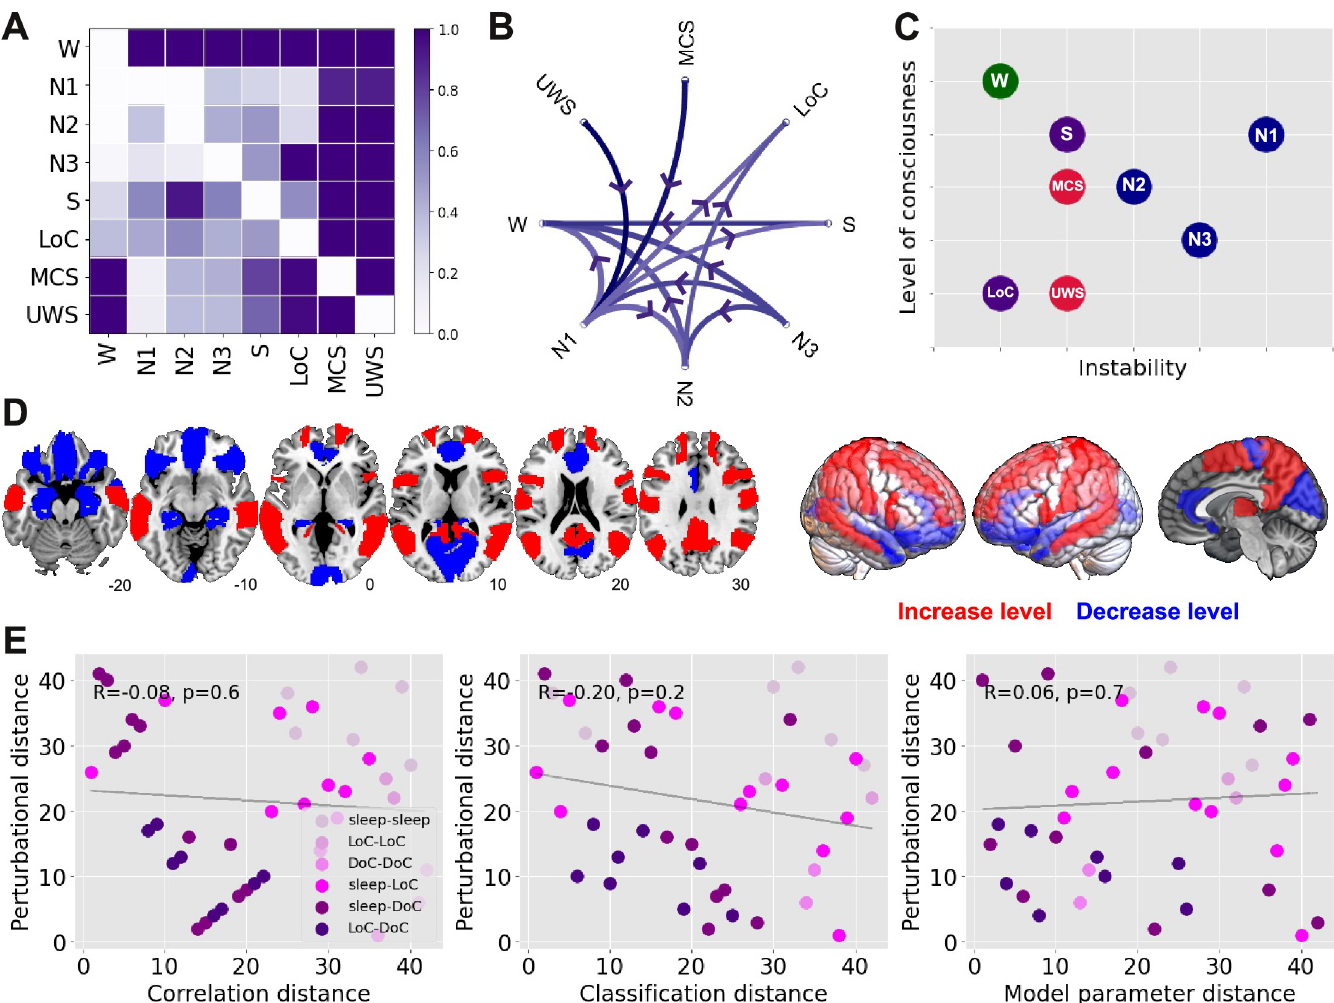
Fig 5. A perturbational metric for the distance between states of consciousness. (A) Matrix representation of the perturbational distance between all pairs of brain states. (B) Directed graph representation of the matrix in Panel A, showing the possible externally-induced transitions between pairs of states of consciousness (thresholded at Δ GoF � 0.3). (C) Two-dimensional diagram of all states of consciousness according to their level of consciousness (i.e. similarity to its corresponding wakefulness in terms of model distance metric) and their instability against external perturbations (sleep states are indicated in blue, S and LoC in purple, and DoC in red). (D) Homotopic regions associated with the best Δ GoF changes in transitions towards states of reduced consciousness (blue) and increased consciousness (red). (E) Scatter plots illustrating the non-significant correlation between perturbational and descriptive distance metrics. Each point represents a pair of states, and the shade of purple indicates one of the following combinations of states: sleep-sleep, LoC-LoC, DoC-DoC, sleep-LoC, sleep-DoC, LoC-DoC. Since variables were converted to ranks prior to the visualization, R and p represent the Spearman’s rank correlation coefficient and its associated p-value, respectively.